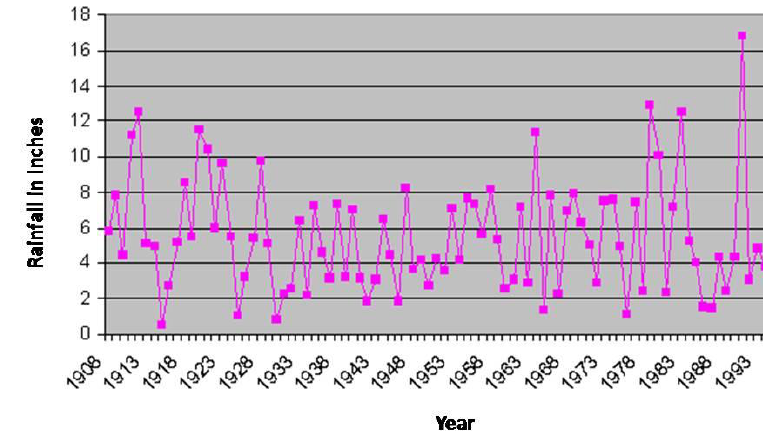
Figure 1. Intensity of the rainfall events after 1970 in the central Mississippi